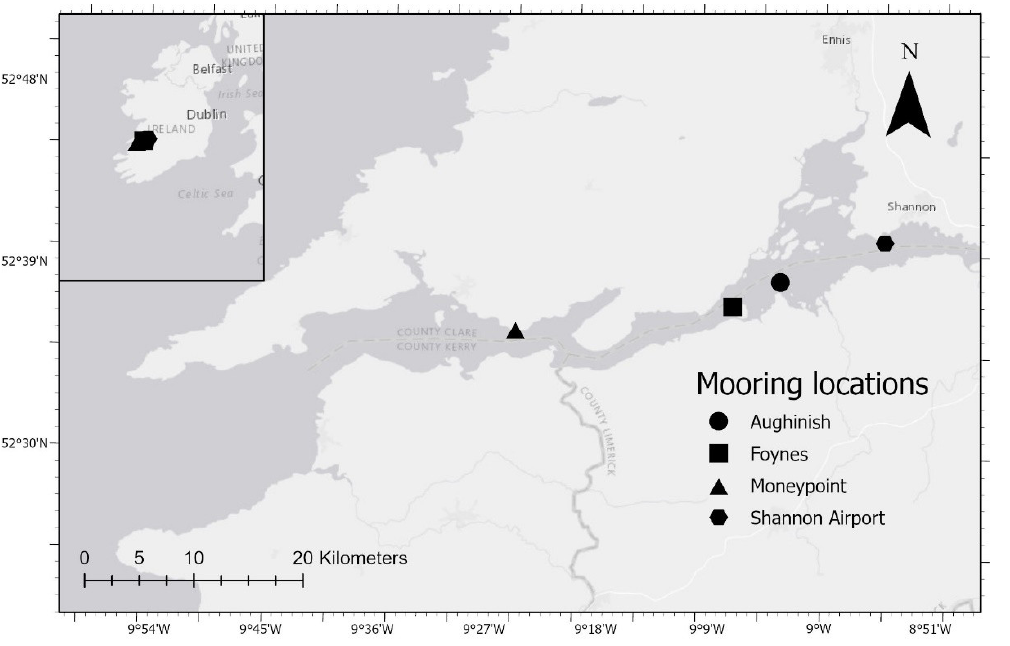
Figure 1. Map of the Shannon Estuary with the locations of C-POD deployment. Table 1. Monitoring period and days monitored for every